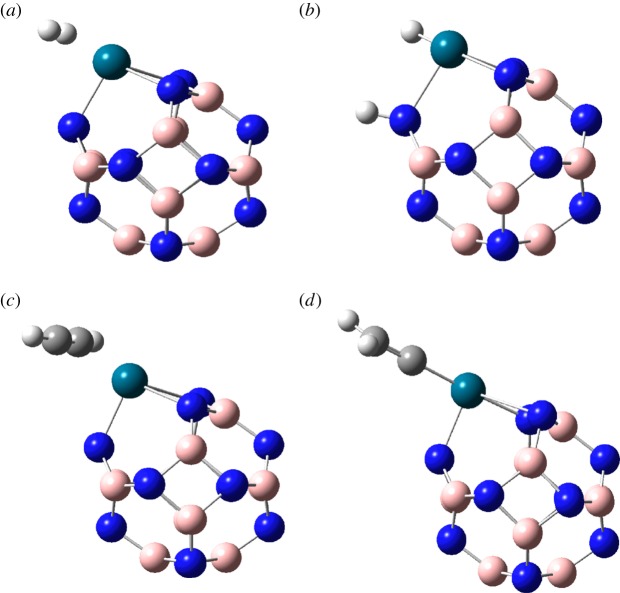
The stable structures of H2 and C2H2 absorbed on B11N12Pd SAC. H, white; B, pink; N, blue; Pd, blue-green.